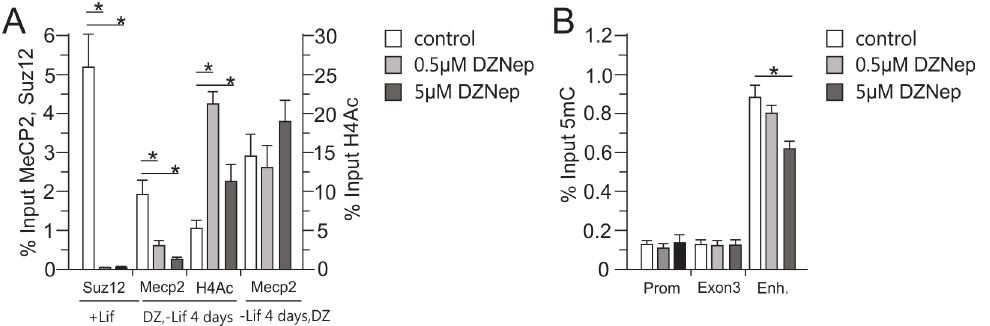
Figure 6. A, DZNep treatment inhibited Suz12 occupancy and Mecp2 recruitment at the Avp enhancer during hypothalamic-like differentiation of EB5 cells. Chromatin samples from cells treated with DZNep during differentiation were immunoprecipitated with antibodies against Suz12, Mecp2 or H4Ac and recovered DNA analyzed by qPCR for the presence of the Avp enhancer. Cells treated with DZNep (DZ) in the undifferentiated state for 24 hrs ( + Lif) showed strongly reduced Suz12 binding. Following 4 days of differentiation (DZ,-Lif 4 days), Mecp2 binding was decreased while H4Ac was increased. In contrast, following 3 days of differentiation an additional 24 hours application of DZNep (-Lif 4days, DZ) did not affect Mecp2 occupancy. B, DZNep treatment led to reduced methylation at the Avp enhancer. MeDIP evidenced reduced 5hmC at the downstream enhancer in response to increasing doses of DZNep, while methylation levels at the promoter and gene body regions did not change. Bars represent standard deviations from the mean (sem), *, P , 0.05; from 5 independent experiments performed.